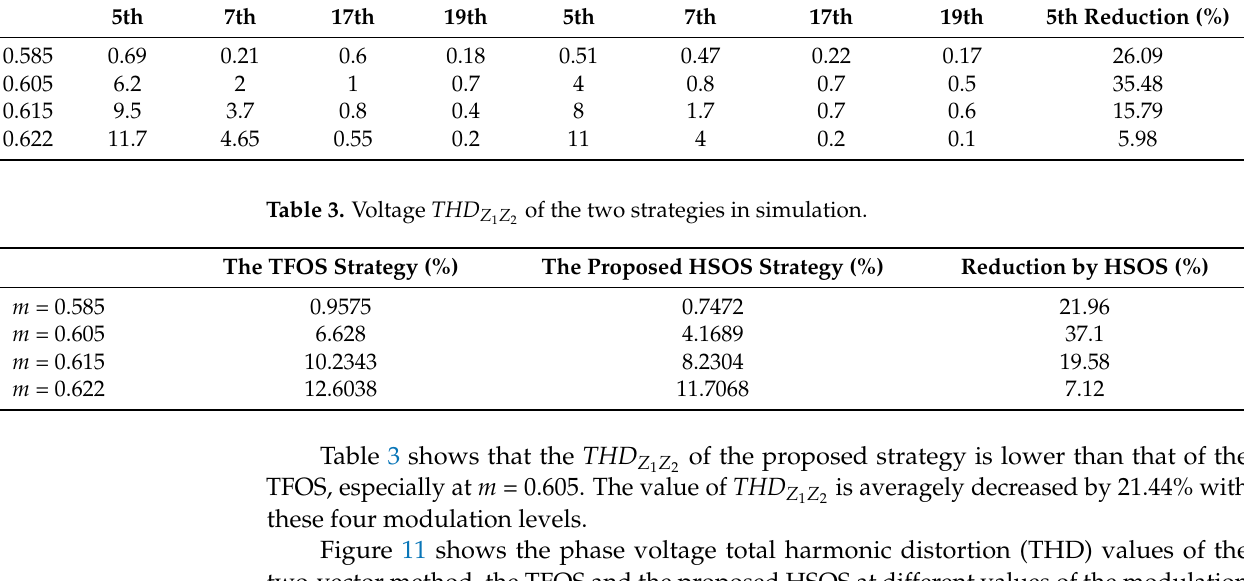
Table 2. Simulation results of the two strategies.